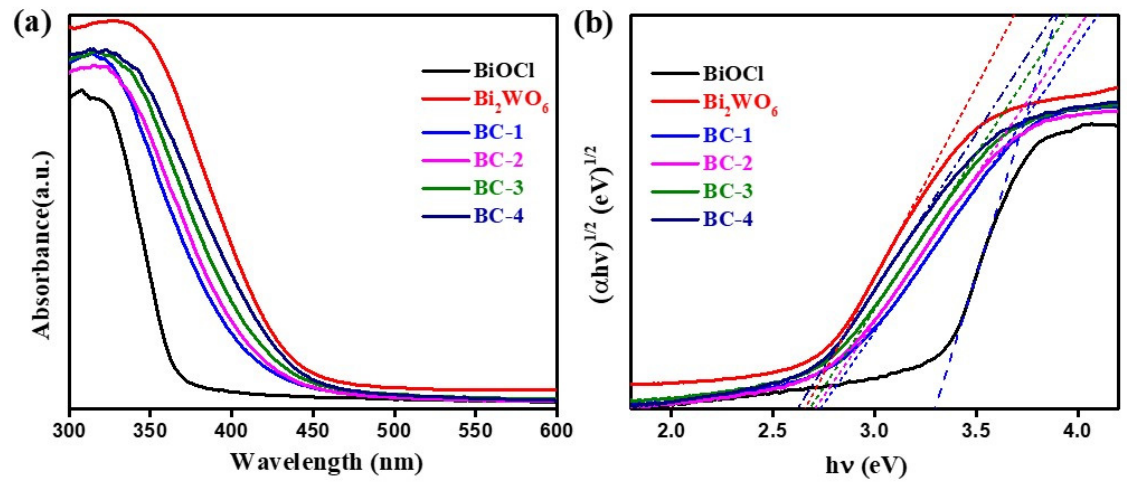
Figure 6. UV-vis DRS ( a ) and Tauc plots ( b ) of pure BiOCl, Bi 2 WO 6 , and Bi 2 WO 6 /BiOCl nanocomposites.